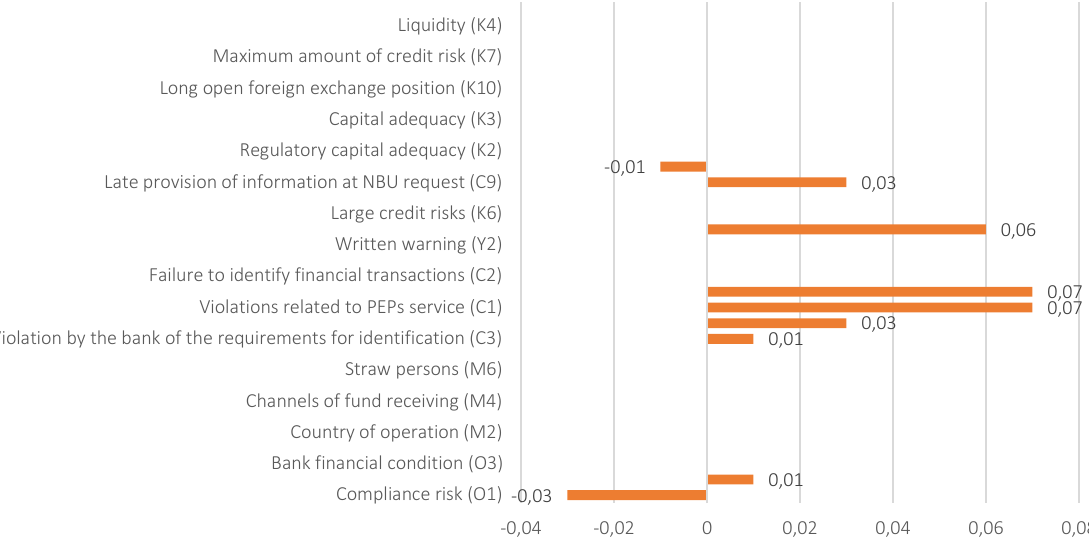
Figure 2. Forecasted variability of compliance indicators and expectations of bank’s counterparties in the non-state pension sphere affected by changes in the intrabank compliance system